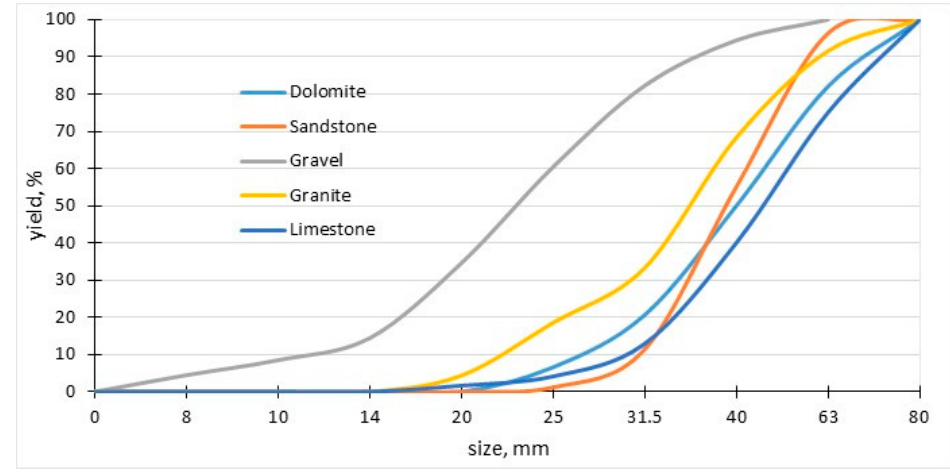
Figure 4. Particle size distribution curves of five feeds sent to the impact crusher. Table 3. Characteristics of the WSR 3-2.0/6.0 rotary screen.